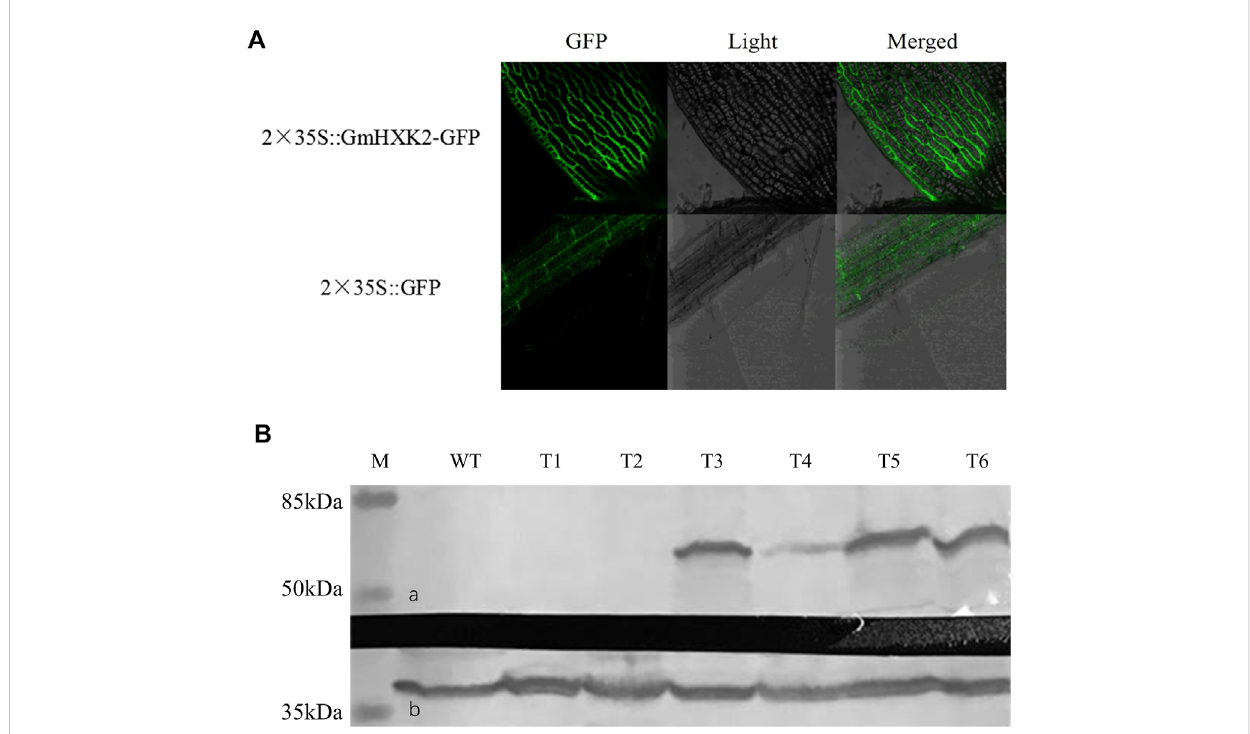
FIGURE 9 Subcellular localization and WB analysis of transgenic plants. (A) . Subcellular localization of GmHXK2 in transgenic Arabidopsis root cells. (B) . Expression of GmHXK2 in transgenic Arabidopsis detected by Western-blot analysis. (A) . GmHXK2 -GFP fusion protein; (B) . GAPDH was used as internal control with molecular mass of 36 kDa (M: Marker; C: Wild type Arabidopsis; T1-T6: transgenic Arabidopsis